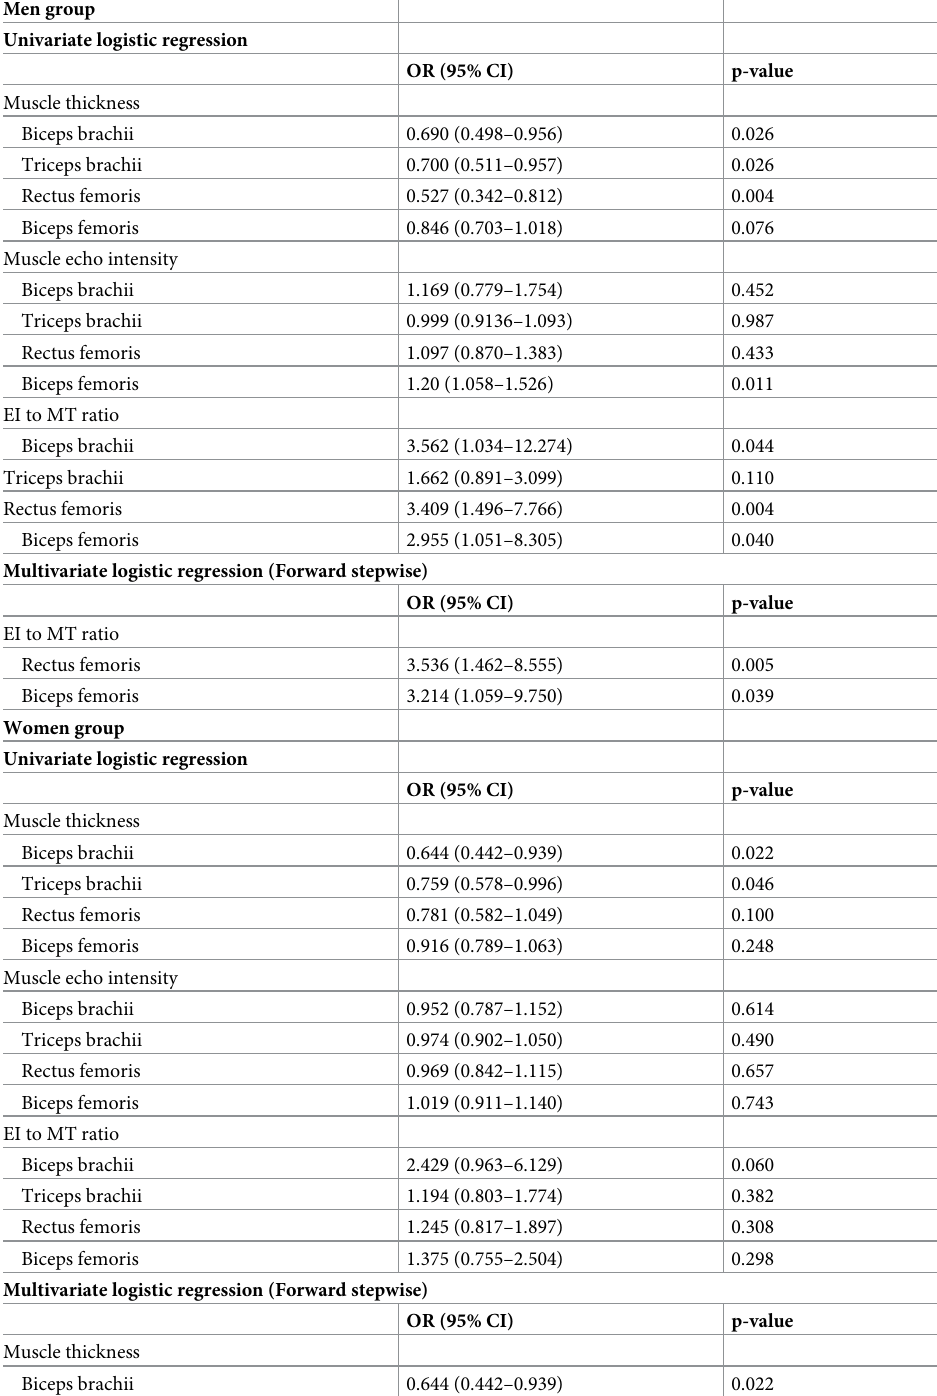
Table 7. Univariate and multivariate logistic regression